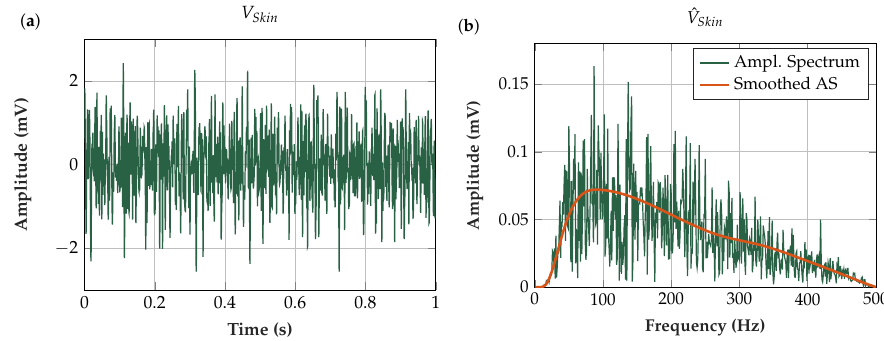
Figure 9. ( a ) Theoretical input signal V Skin in time domain (duration = 1 s, f S = 10 kHz, peak to peak amplitude = 5 mV). ( b ) Amplitude spectrum of the theoretical input signal (resolution ∆ f = 1